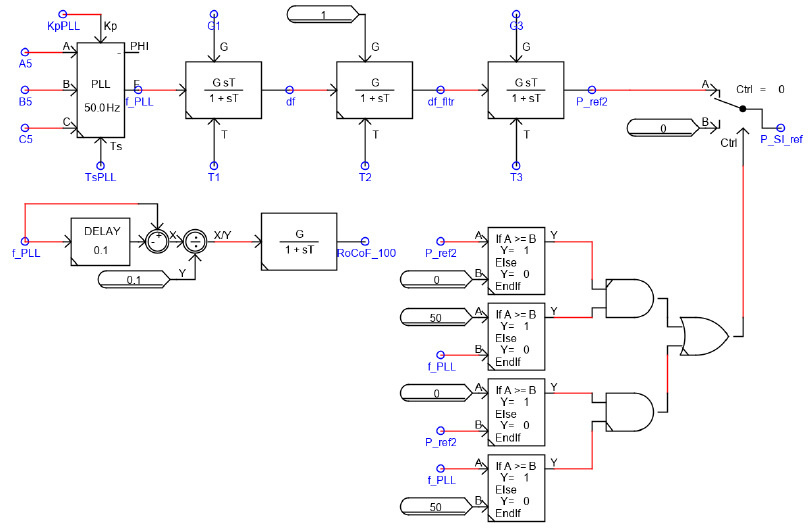
Figure 11. Synthetic inertia control diagram for BESS; the output of the controller can be either signal P_SI: normal operation of SI or blocked blocking criteria are met.